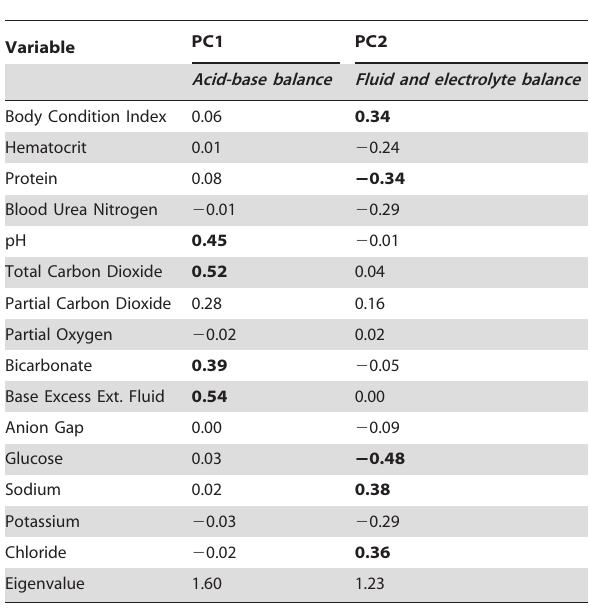
Table 1. Component loadings of blood biochemistry parameters measured in mountain yellow-legged frogs infected with Batrachochytrium dendrobatidis .